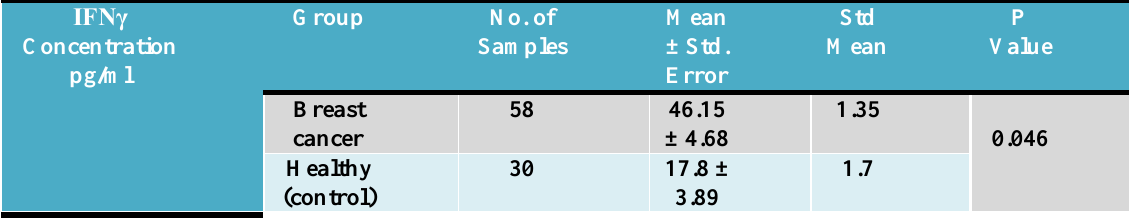
Table 1: Concentration of Interferon gamma (IFN-γ) in serum of healthy subjects and women with breast cancer IFNγ